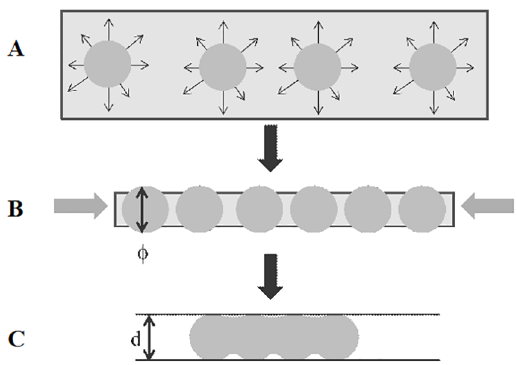
Figure 6. Scheme for the formation of nanowires of latex films by EISA process: (A) - intermolecular forces in the dispersion; (B) - action of capillary force during EISA process; (C) - consolidation of nanowires by coalescence process. ϕ = particle diameter; d = nanowires